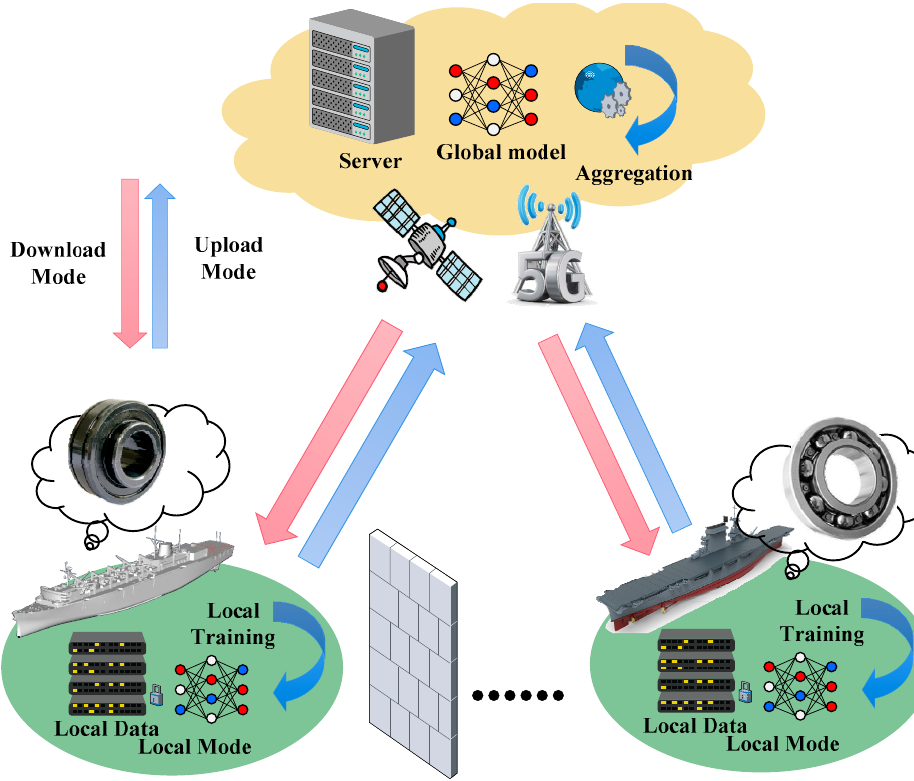
Figure 1. IoT federated learning